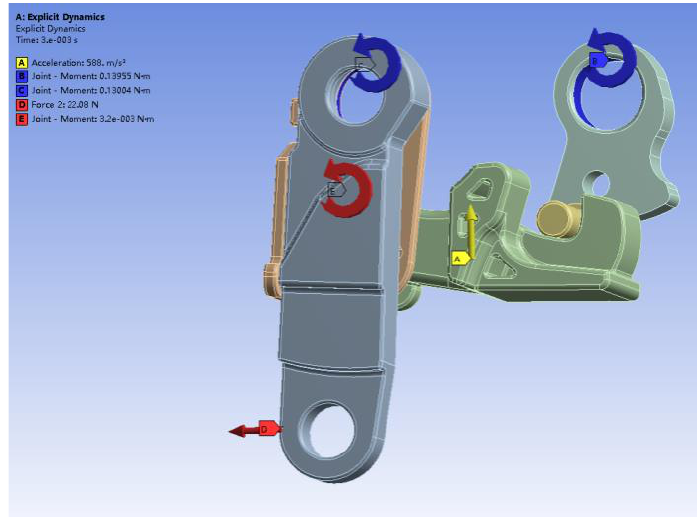
Figure 13. Overall loads and